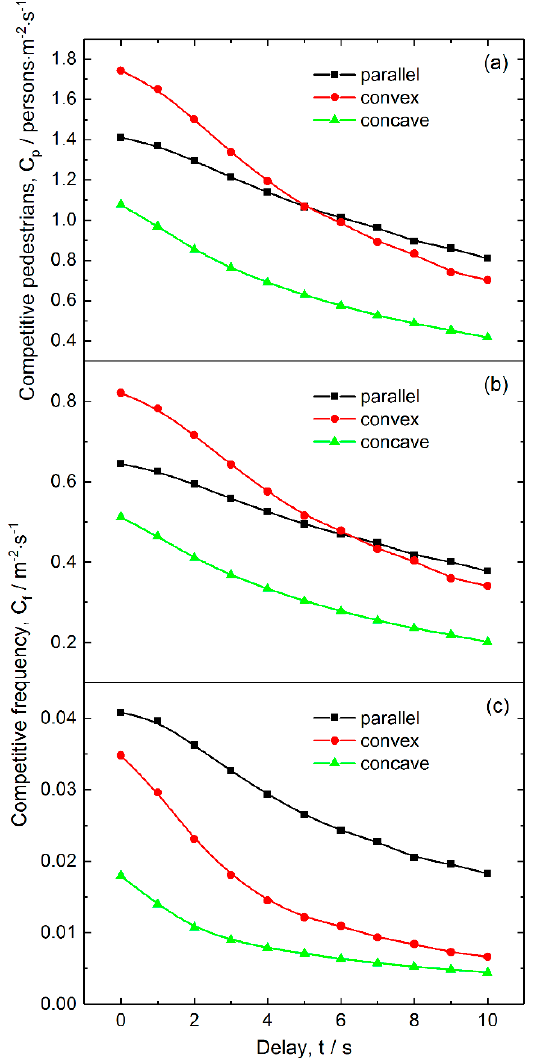
Figure 10. Competitive intensity as a function of average delay for the three layouts of inspection points: ( a ) Competitive pedestrian-time, ( b ) two-person competitive frequency and ( c ) three-person competitive frequency. The pedestrian density and average delay are 3.5 persons/m 2 and 3 s, respectively.